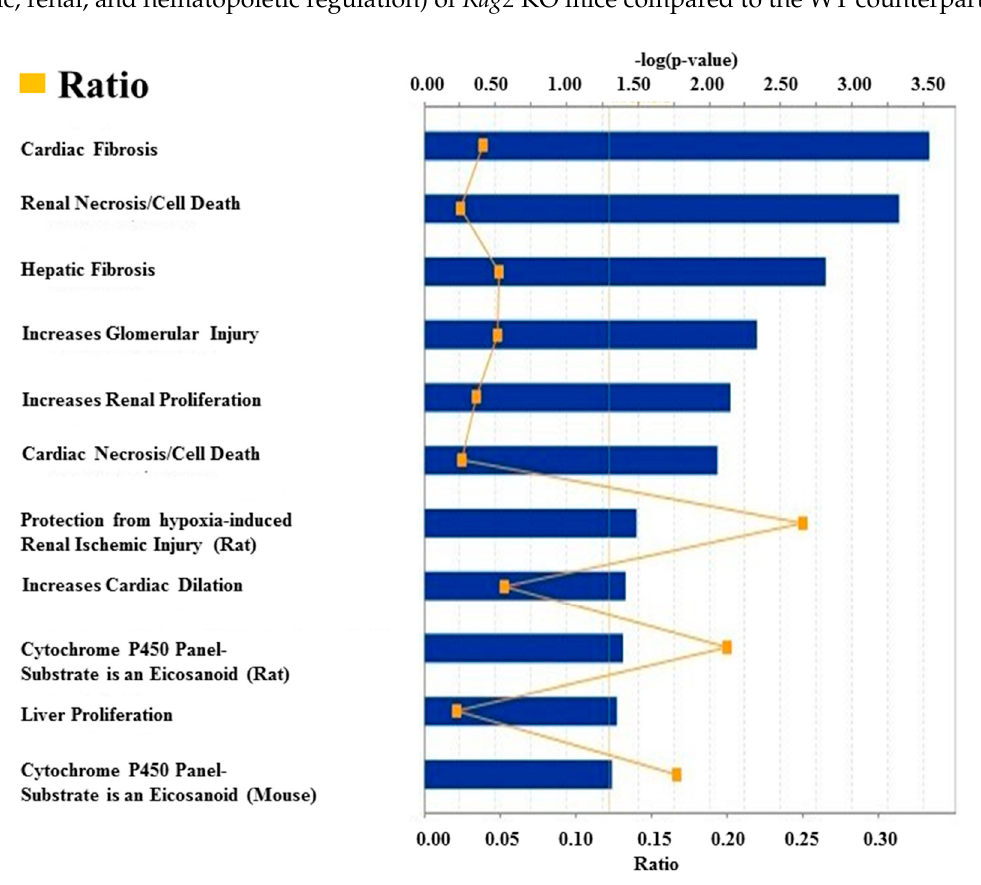
Figure 2. Ingenuity Pathway Analysis (IPA) toxicity list linking the experimental data with the potential clinical and pathological endpoints in Rag2 KO mice. In this figure, the top potential clinical and pathological phenomena are listed. They are predicted to be present in Rag2 KO mice, and include (but not limited to) cardiac abnormalities, renal necrosis/cell death, hepatic fibrosis and glomerular injury.